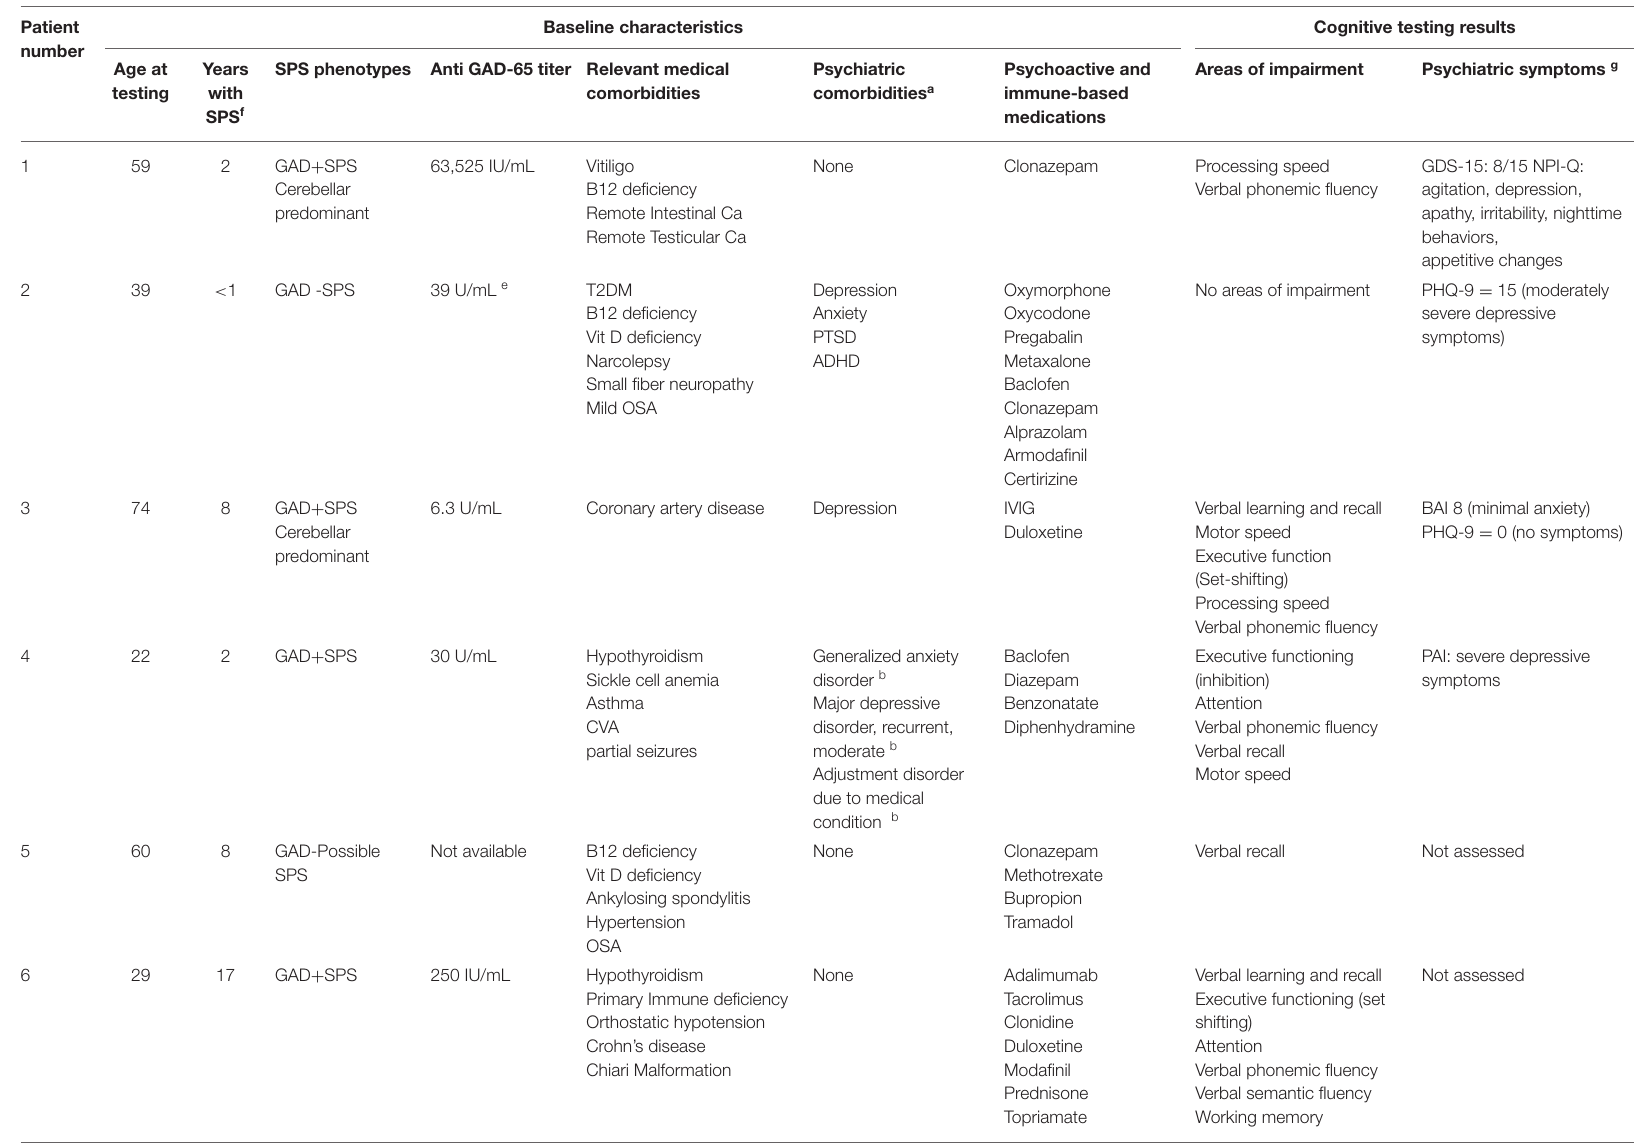
TABLE 1 | Clinical and laboratory features of patients with stiff person syndrome spectrum disorders who received formal cognitive testing as part of routine clinical care for patient-reported cognitive